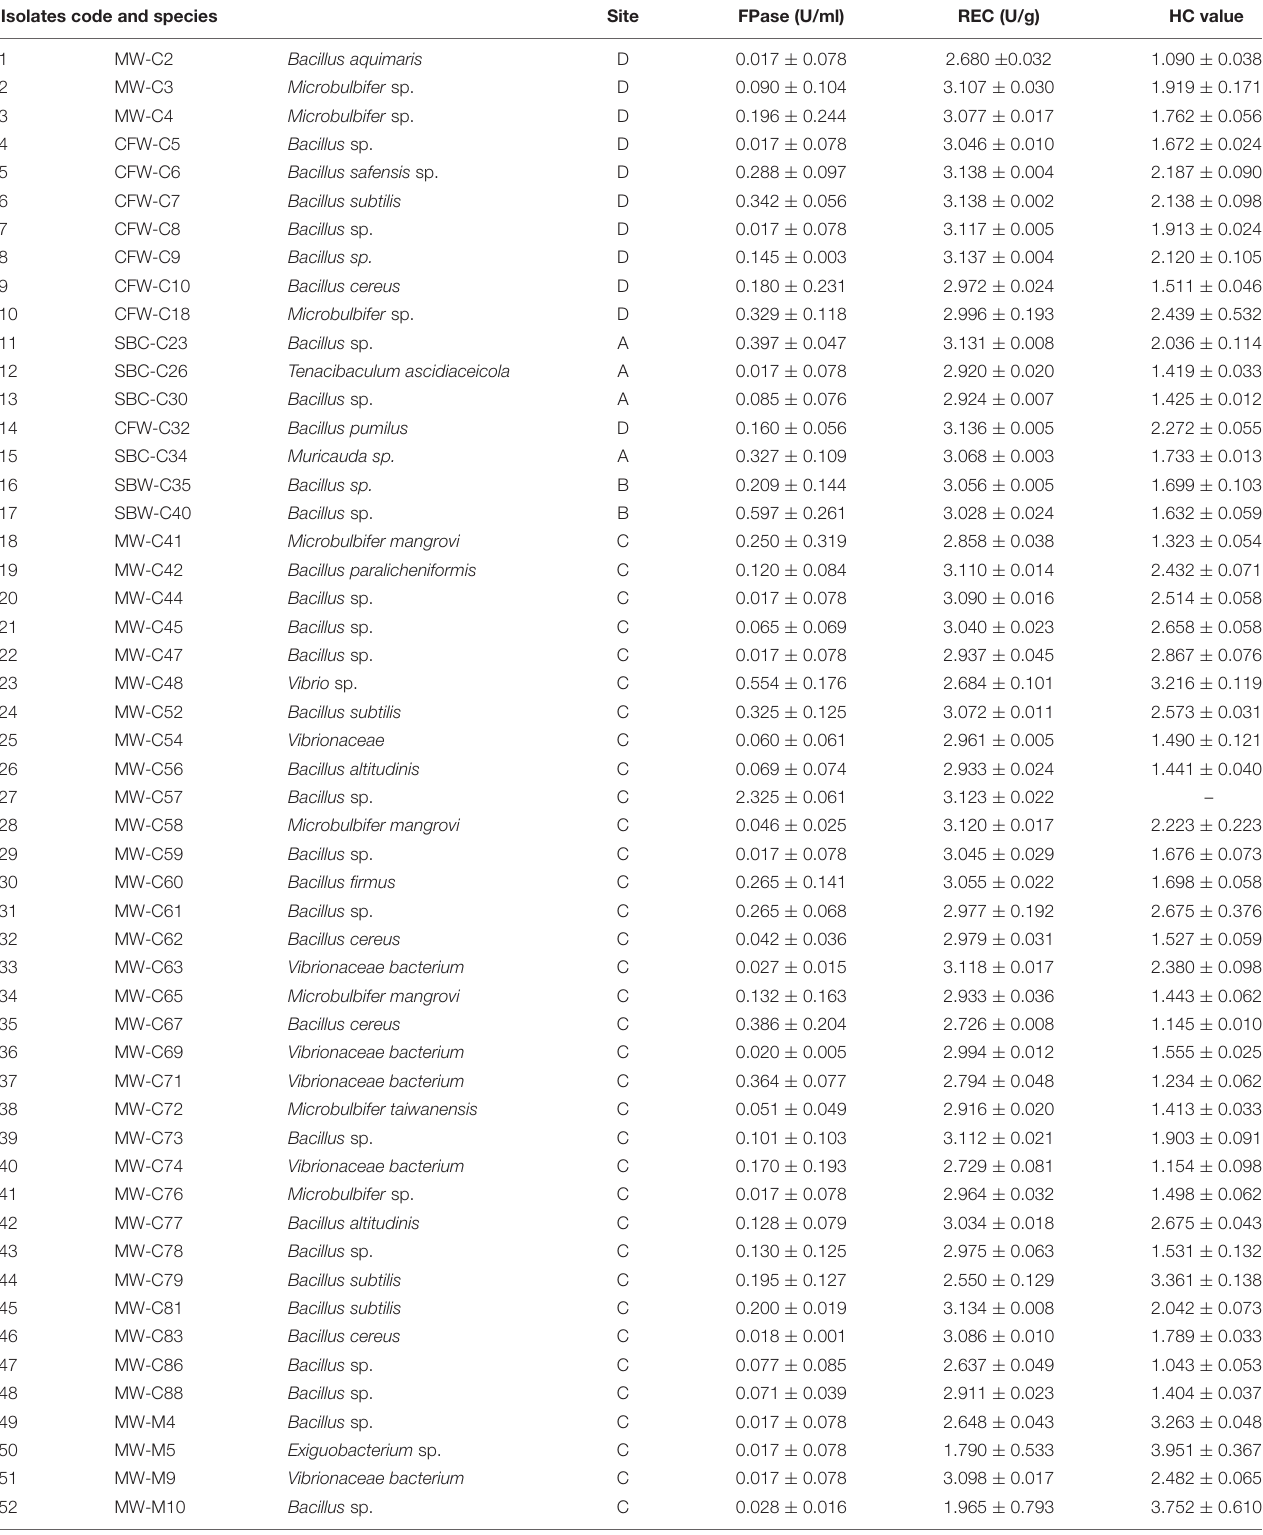
TABLE 1 | FPase, relative enzyme content (REC), and hydrolysis capacity (HC) values of 58 cellulolytic bacteria. Isolates code and species